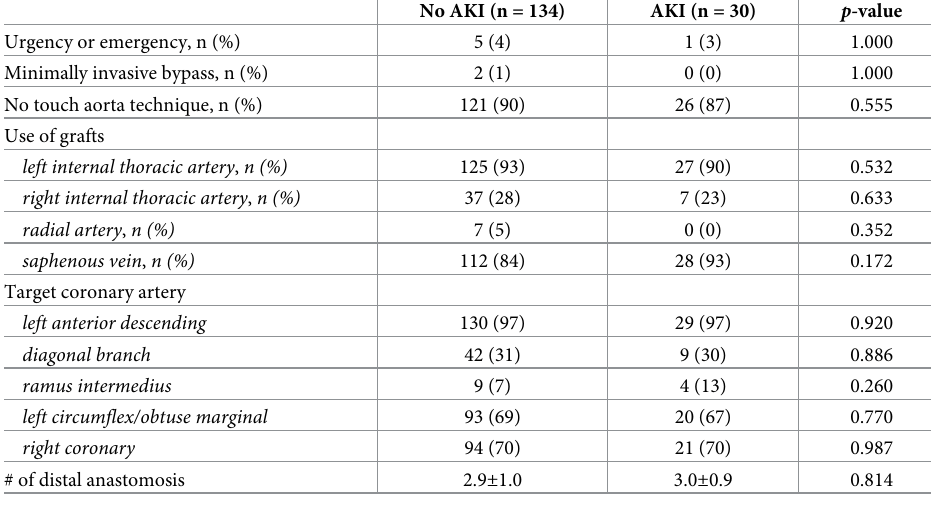
Table 2. Comparison of surgical techniques, used grafts, and target vessels.